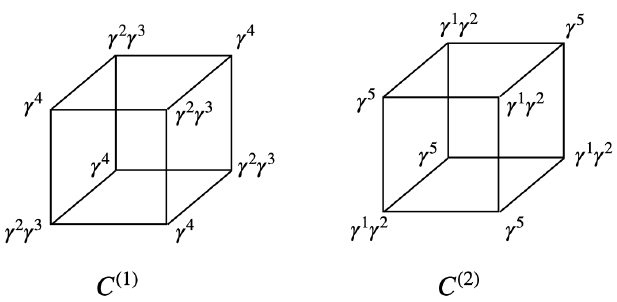
Figure 3: Cubes obtained from the effective field